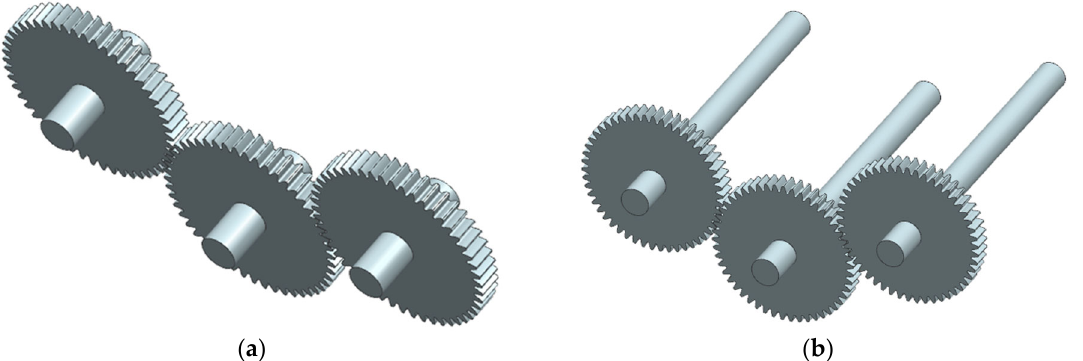
Figure 1. Gear and shaft models for ( a ) dynamic transmission error and ( b ) contact pressure distribution studies.